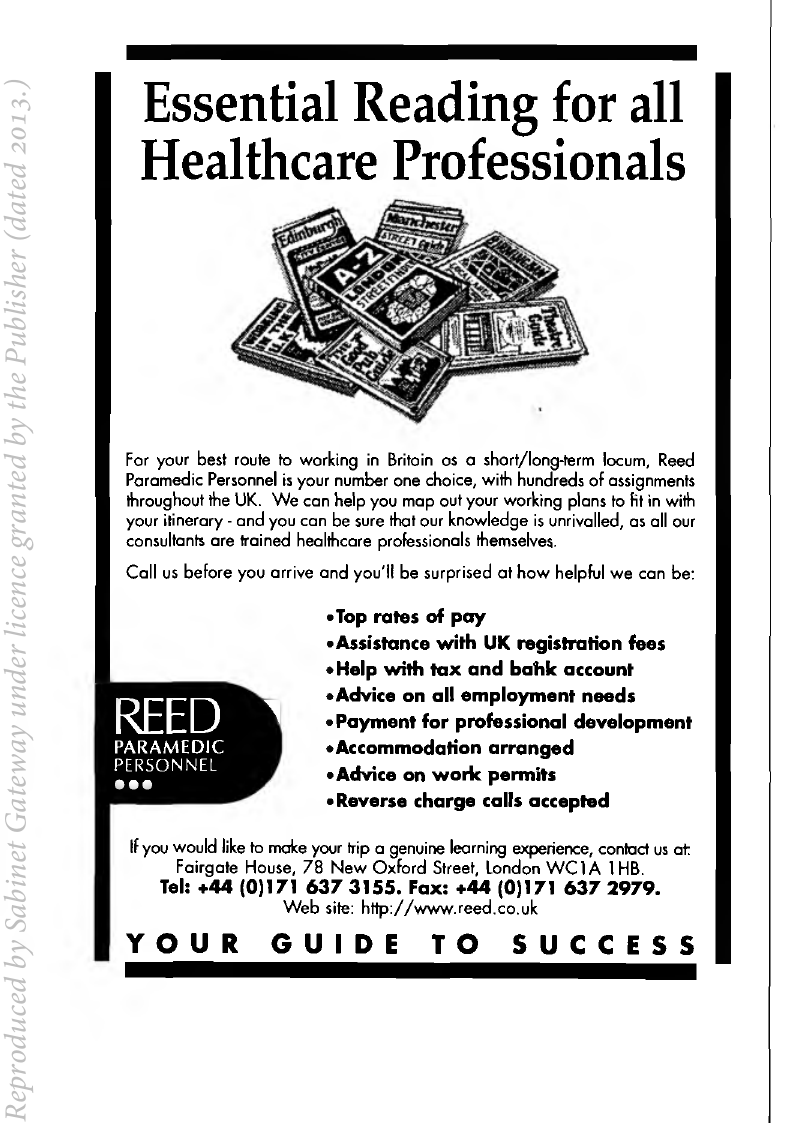
Section F: The section on neonates and infants